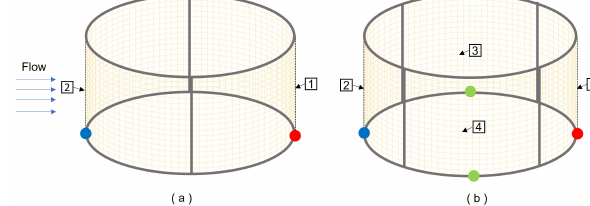
Figure 4: Two configurations of splitting up a circular net pen and the corresponding arrangement of positioning sensors. (a) A net cage equally divided by two as an upstream part (panel 2) and a downstream part (panel 1); (b) A net cage equally divided by four as an upstream part (panel 2), a downstream part (panel 1) and two side parts (panel 3 and 4)